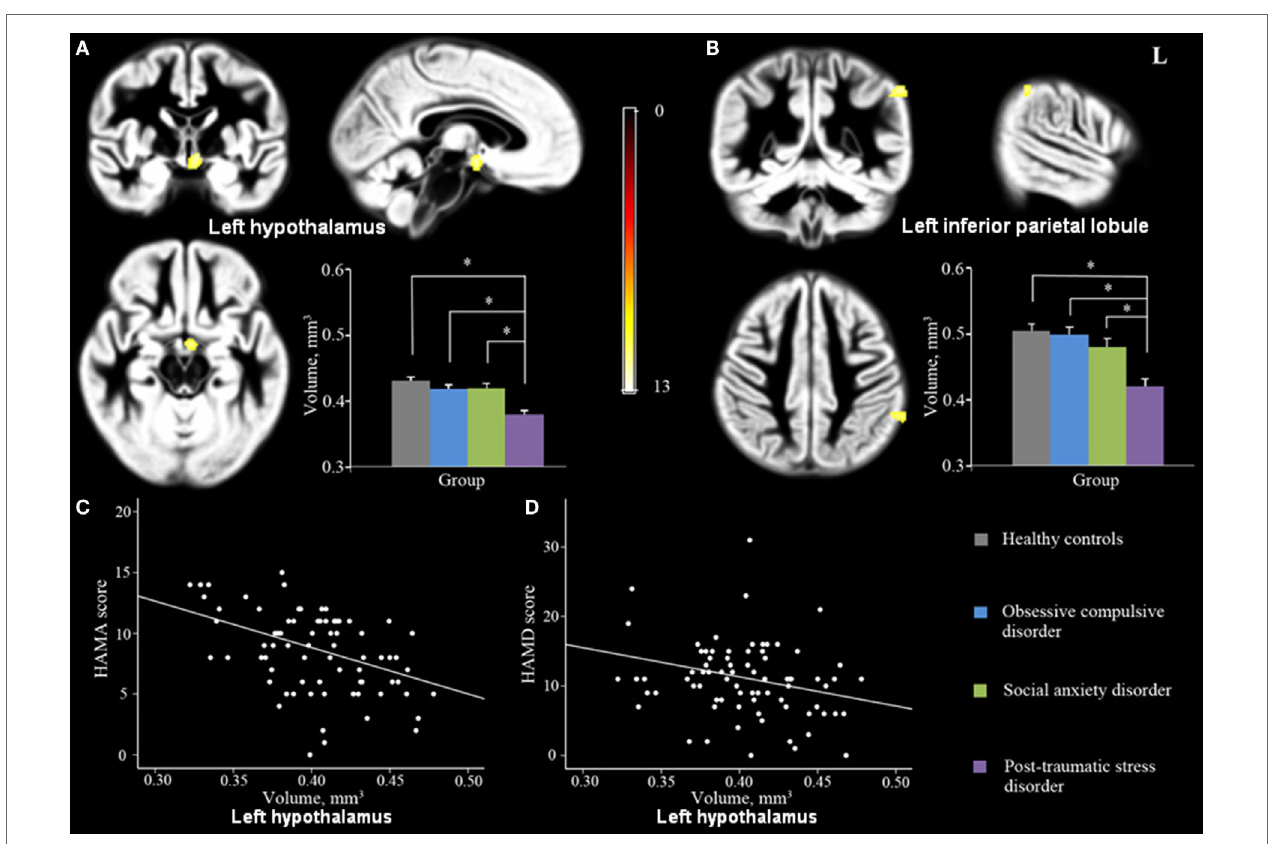
size of 70 voxels after FWE correction for whole-brain volume, age, and gender). Abbreviations: GMV, gray matter volume; DARTEL, Diffeomorphic Anatomical Registration Through Exponentiated Lie; HAM-A, Hamilton Rating Scale for Anxiety; HAM-D, Hamilton Rating Scale for Depression; IPL, inferior parietal